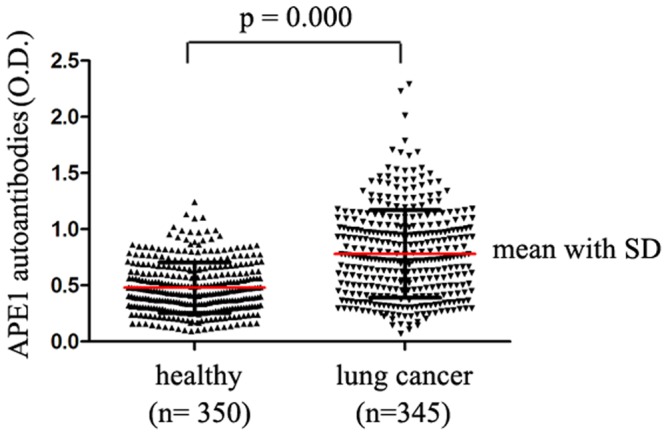
Serum APE1-AAbs level in NSCLC patients and healthy subjects assessed by ELISA.Among 292 NSCLC patients, the mean with SD of APE1-AAbs concentration was 0.79±0.40 (OD450), which was significantly higher than 0.47±0.22 (OD450) in healthy volunteers (p = 0.000, t-test).